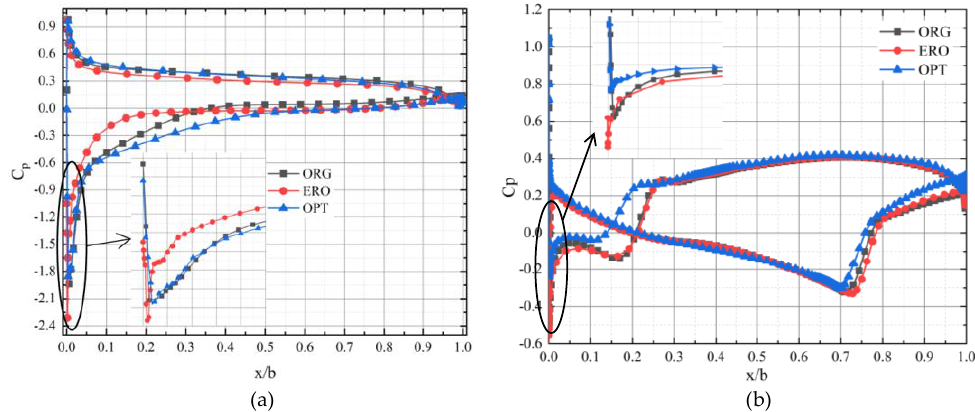
Figure 18. Static pressure of original and eroded blade at design point: ( a ) Pressure around the rotor blade at mid-span and ( b ) pressure around the rotor blade near the tip.